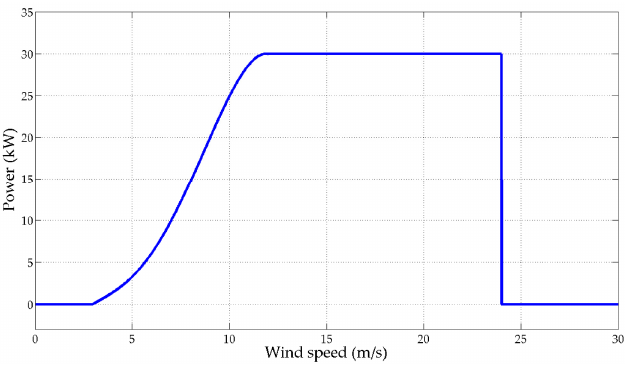
Figure 1. Power output curve of wind turbine (WT).